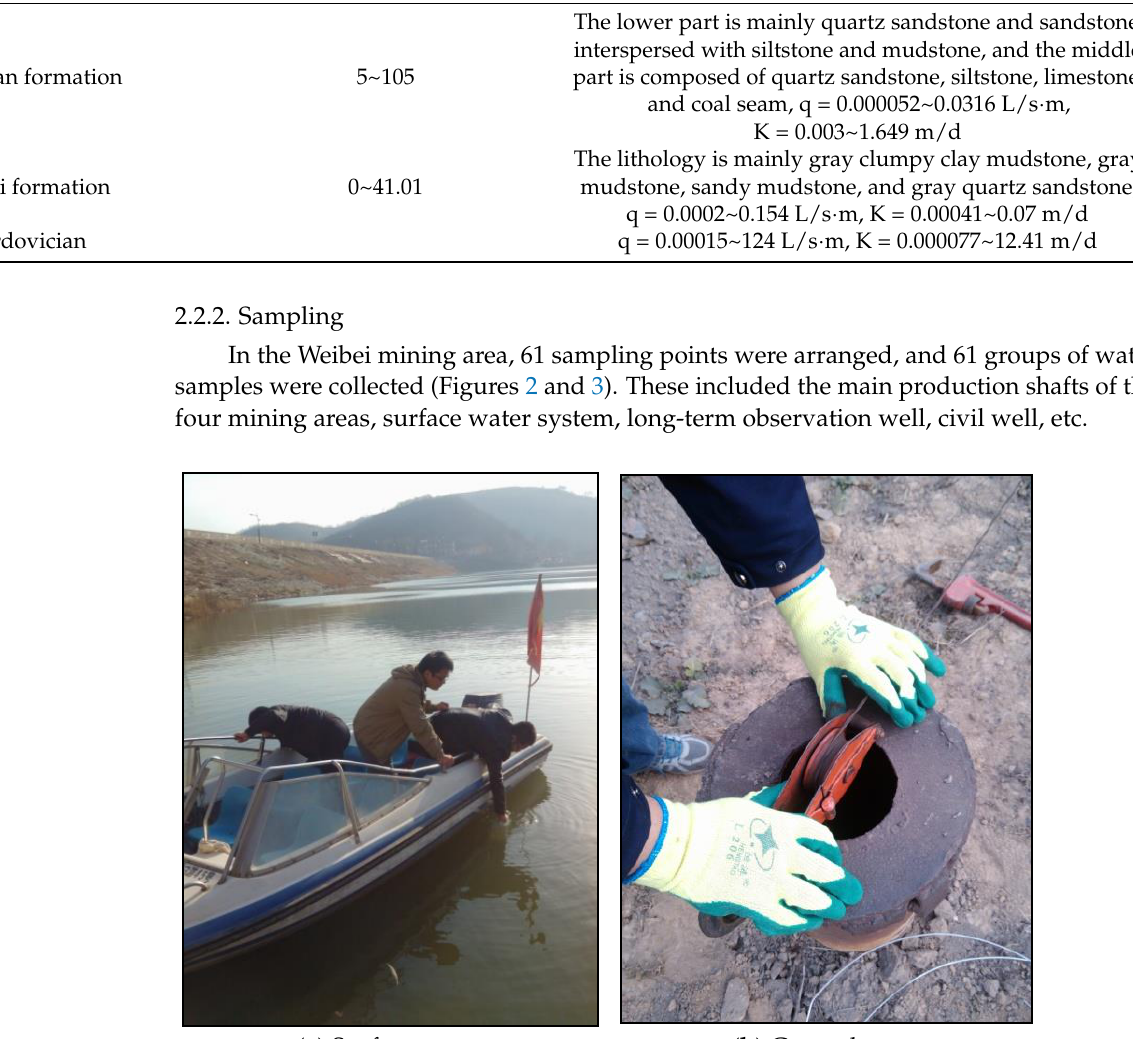
Figure 3. Sampling Points.